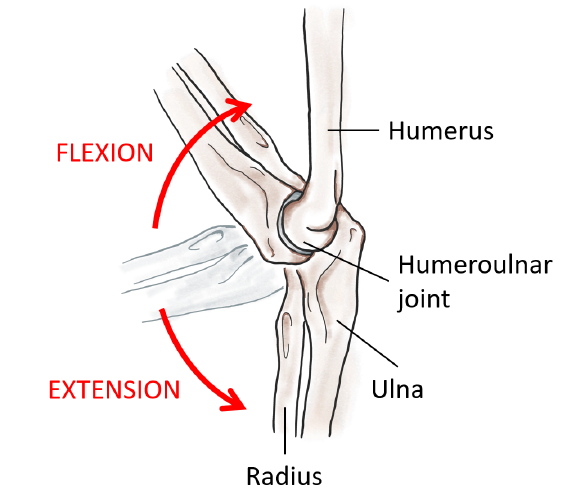
Figure 1. Anatomy of the elbow and movement of flexion–extension of the joint